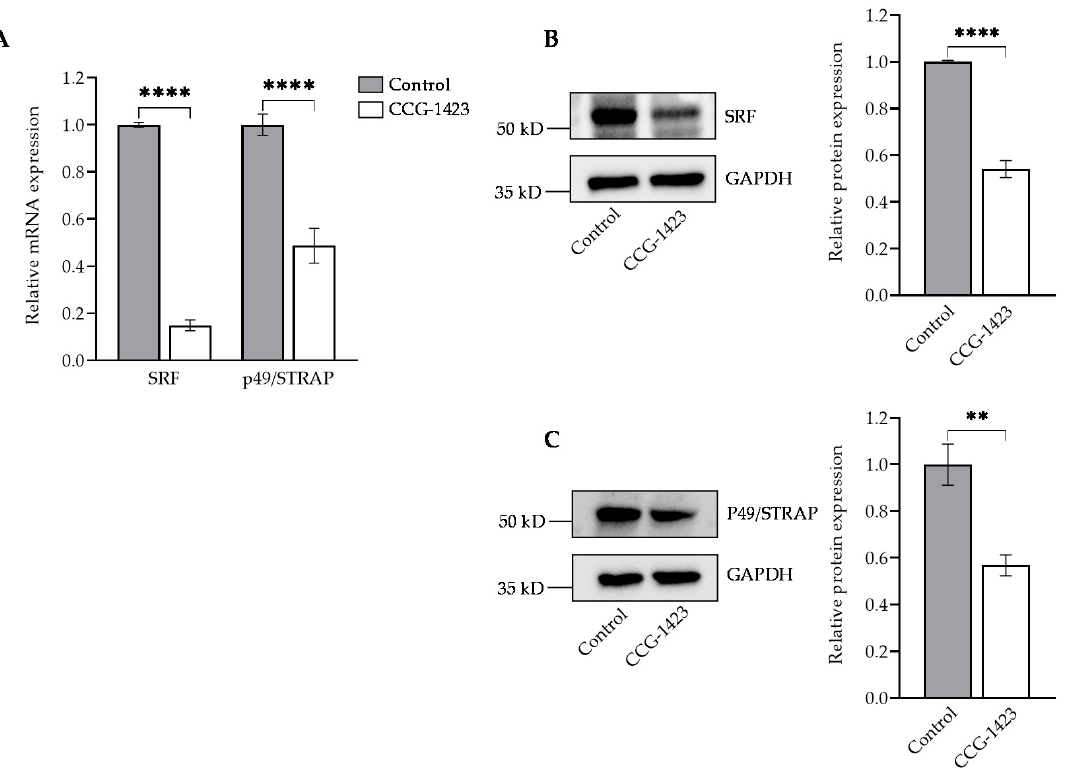
Figure 1. CCG-1423 represses SRF and p49/STRAP. ( A – C ) C2C12 cells were treated with a 10 μ M dosage for 24 h. ( A ) The mRNA expression of SRF and p49/STRAP was evaluated in qPCR. DMSO was used as control. Immunoblotting was used to evaluate the protein levels of ( B ) SRF and ( C ) p49/STRAP. GAPDH was used as the total protein loading control and relative protein expression was quantified in ( B , C ). ** p < 0.01, **** p < 0.0001 ( n = 3).